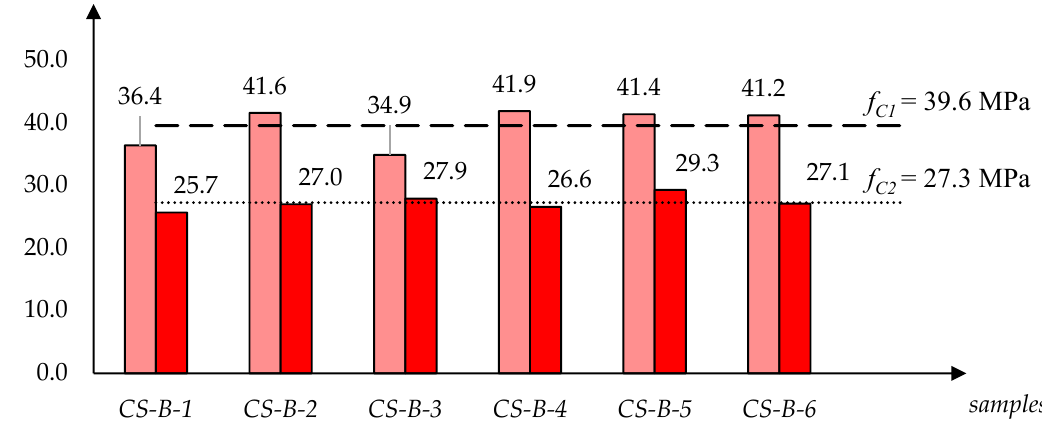
Figure 4. Overview of compressive strength values designated for silicate specimens CS-B-1–CS-B-6 (6 dry and 6 water-saturated), with f C1 (for dry state) and f C2 (for saturated state) averages. A clear tendency of compression strength decrease was observed as a result of water saturation.